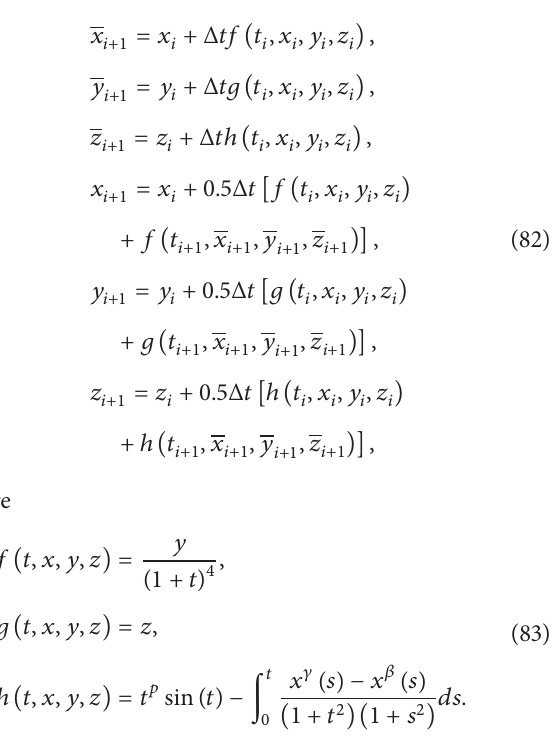
with initial conditions 𝑥(𝑡 0 ) = 𝑥 0 , 𝑥 󸀠 (𝑡 0 ) = 𝑥 󸀠 0 , and 𝑥 󸀠󸀠 (𝑡 0 ) =